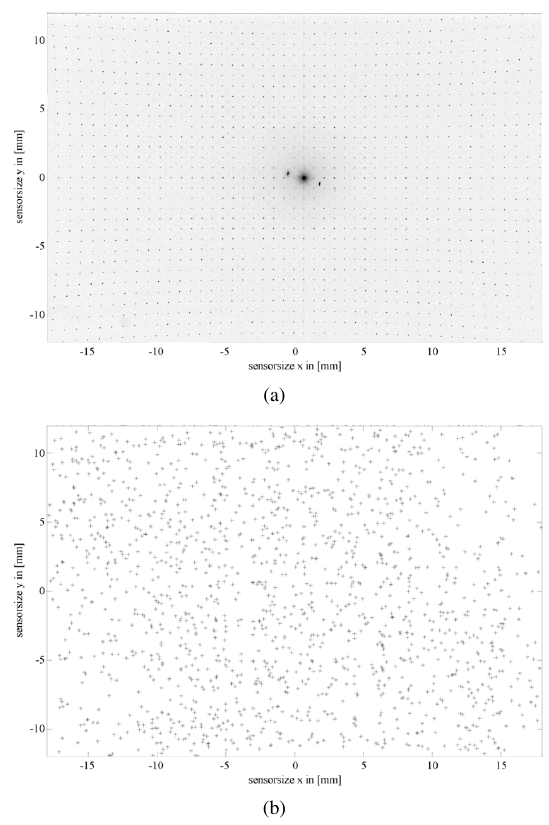
Figure 4. Sensor coverage with GCPs (a) Distribution of 1299 diffraction points (b) Distribution of 1529 GCP observations for